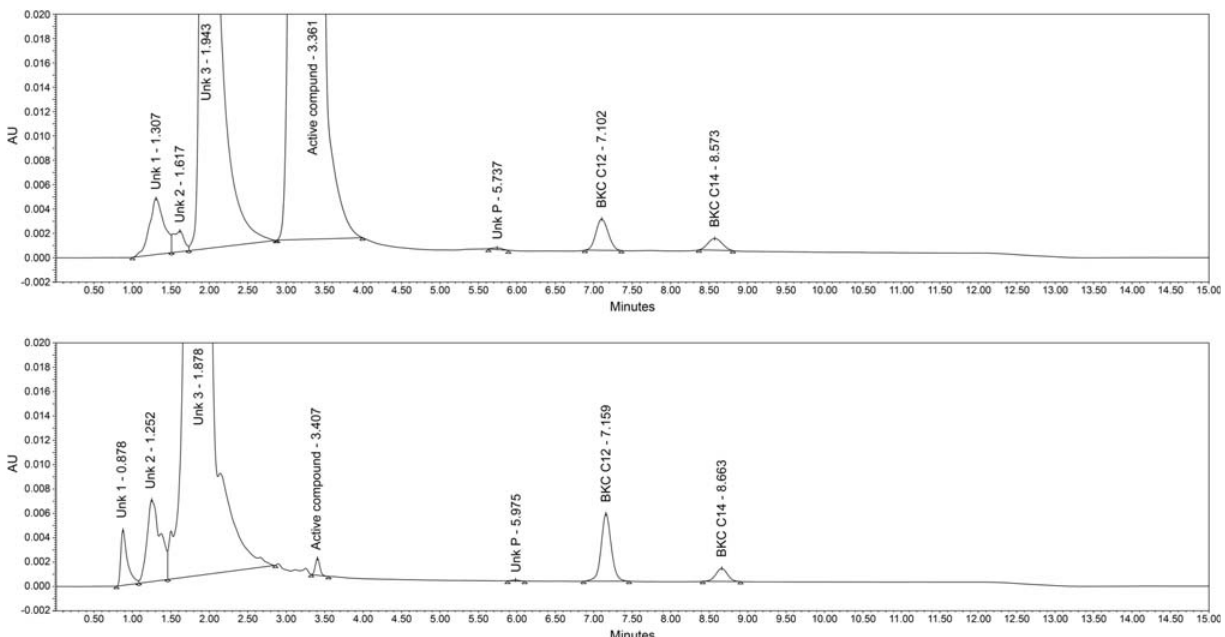
Figure 6. Chromatograms obtained with the initial sample preparation (top) and the optimized sample preparation (bottom) analyzed by the opti- mized HPLC method. The interfering placebo peak in the chromatograms is labelled as UnkP and benzalkonium chloride homologs as BKC C12 and BKC